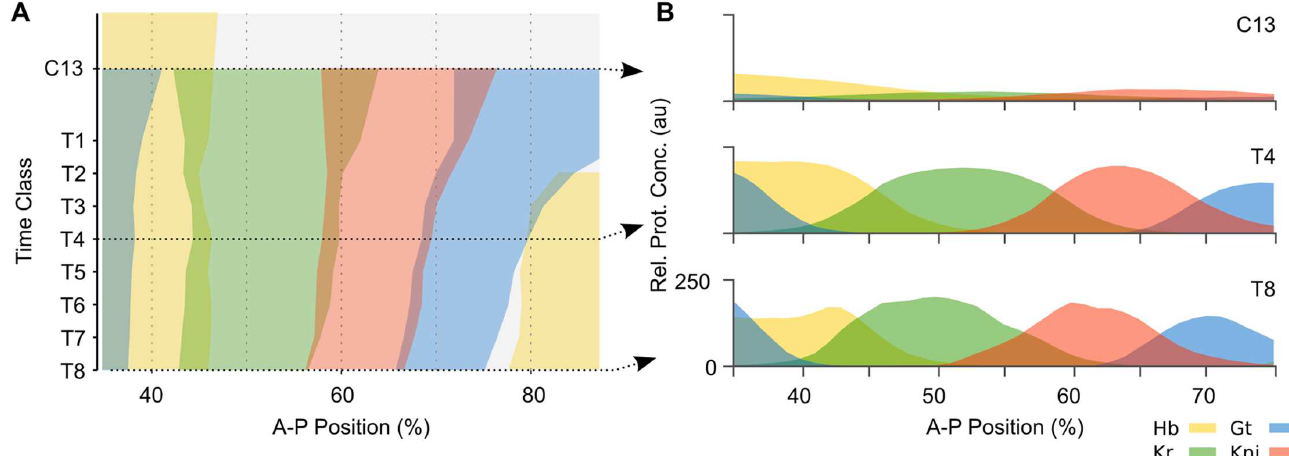
Fig 1. Dynamicsof gap gene expression. (A) Space-time plot of protein expressiondata for the trunk gap genesduringthe late blastoderm stage in D. melanogaster . Colouredareas demarcateregions with relative protein concentration abovehalf-maximum value. Time flows downwardsalong the y-axis. (B) Cross-sections of gene expressionin (A) at cycle C13 and time classes C14A-T4 and T8 (dashedarrows in (A)). Y-axes indicaterelative protein concentration in arbitrary units (au). In both panels, x-axes represent %A–P position, where 0% is the anterior pole. Hunchback(Hb) is shown in yellow, Kru¨ppel (Kr) in green, Knirps (Kni) in red, and Giant (Gt) in blue. C13: cleavagecycle 13; C14A-T1–8: cleavagecycle 14A, time classes 1–8 (see Models and Methods for details).